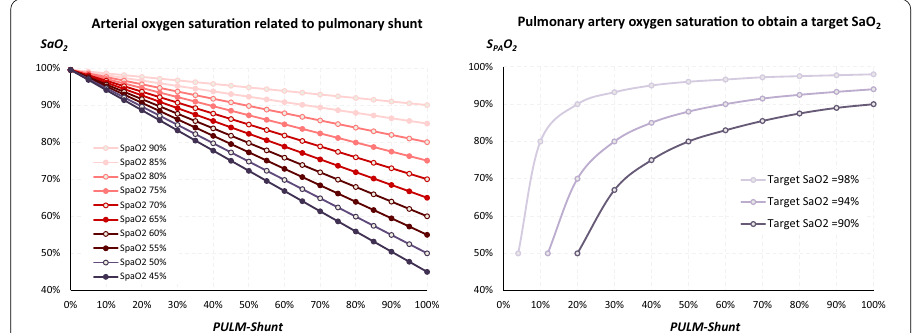
Fig. 2 Relationship between SaO 2 and S PA O 2 according to pulmonary shunt. When lung function is optimal (PULM-Shunt 0%), SaO 2 is equal to 100% regardless the S PA O 2 value. In contrast when residual lung function = is null (PULM-Shunt 100%), SaO 2 is equal to S PA O 2 . Between these two clinical status, the relationship SaO 2 * = PULM-Shunt is linear with a slope that directly depends on S PA O 2 . The S PA O 2 value is the final consequence of ECMO therapy in term of oxygenation. PULM-Shunt pulmonary shunt, SaO 2 arterial blood oxygen saturation, S PA O 2 pulmonary arterial blood oxygen saturation